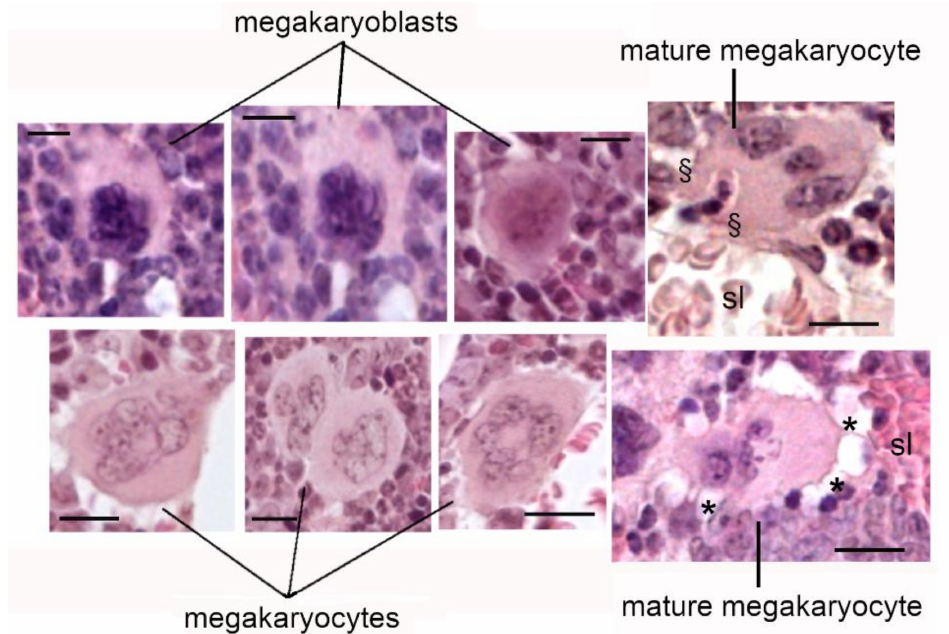
Figure 1. Megakaryocyte (MK) development is a multiphase process divided in four stages: megakaryoblasts, stages I and II; MKs, stages III and IV. sl: sinusoid lumen; * : cytoplasmic processes releasing pro-platelets into the blood stream; § : large protrusion entering the sinusoid lumen. Scale bar = 10 µ